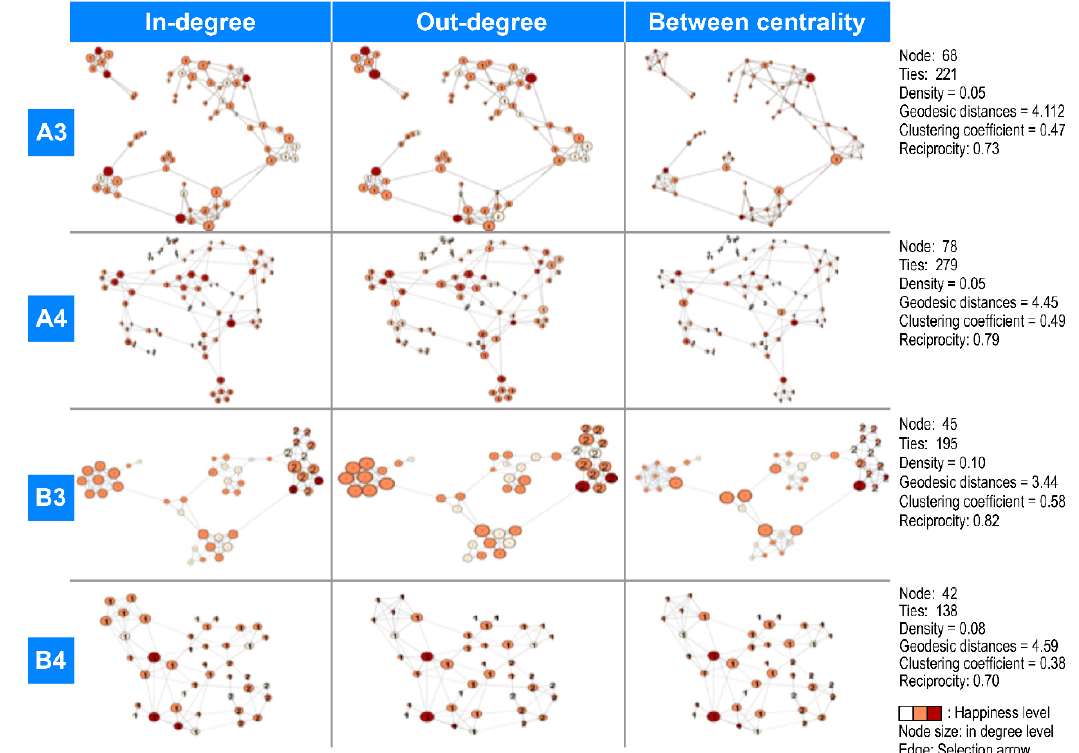
Figure 1. The sociogram of each group. Node color: red = very happy, orange = happy, and white = very unhappy. A3: